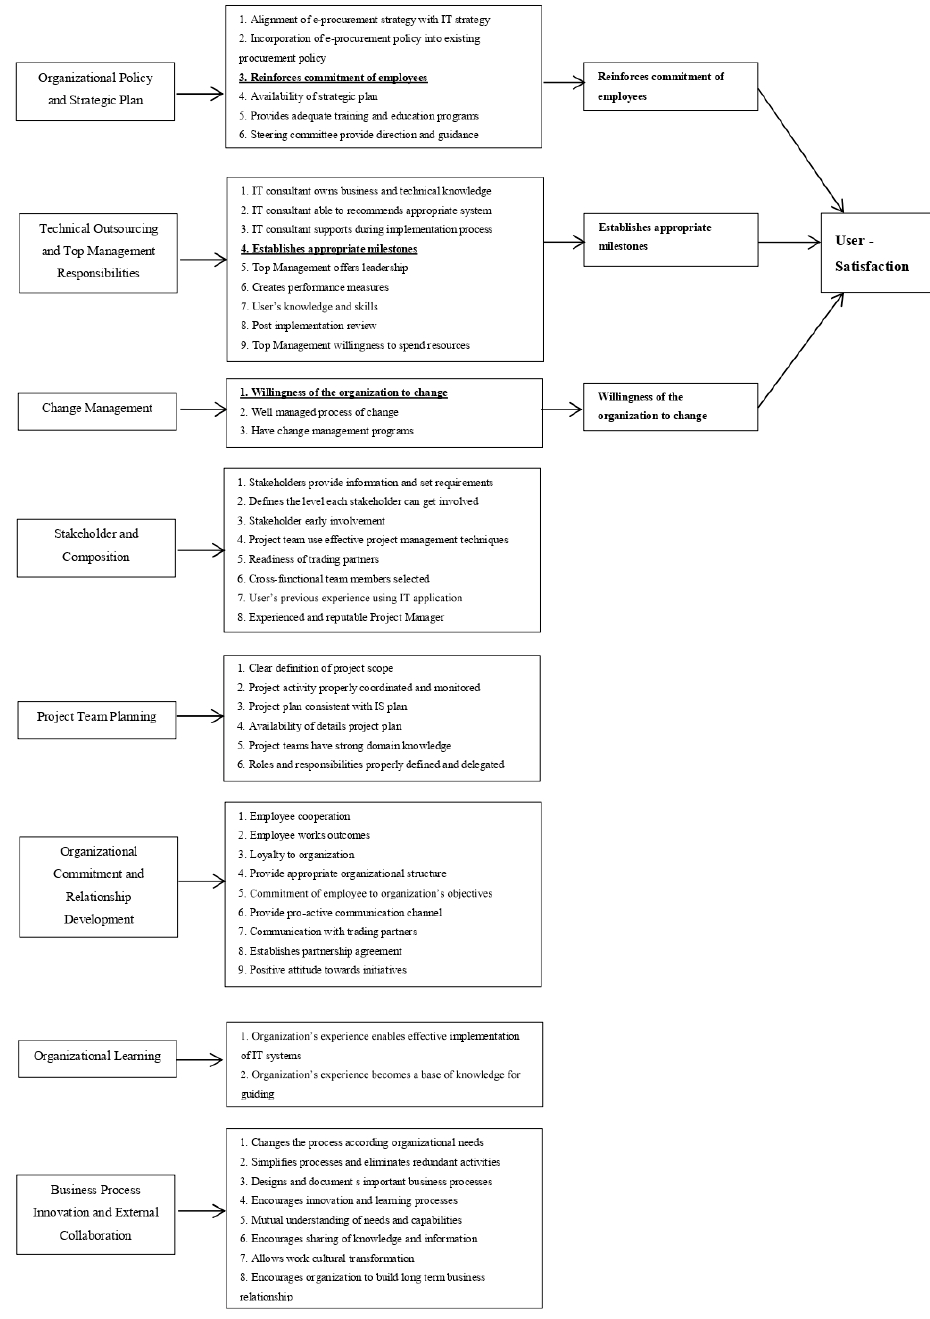
Figure 7. e-procurement Implementation Success (ePIS) framework for user satisfaction.